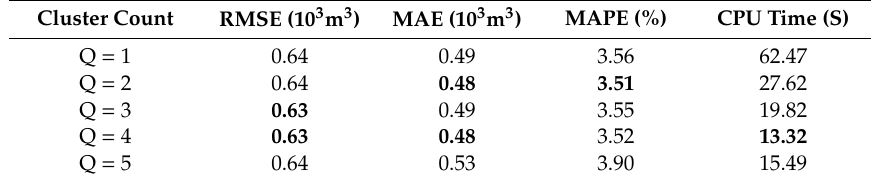
Table 2. Experimental results for candidate clusters (The best metrics are highlighted in bold).